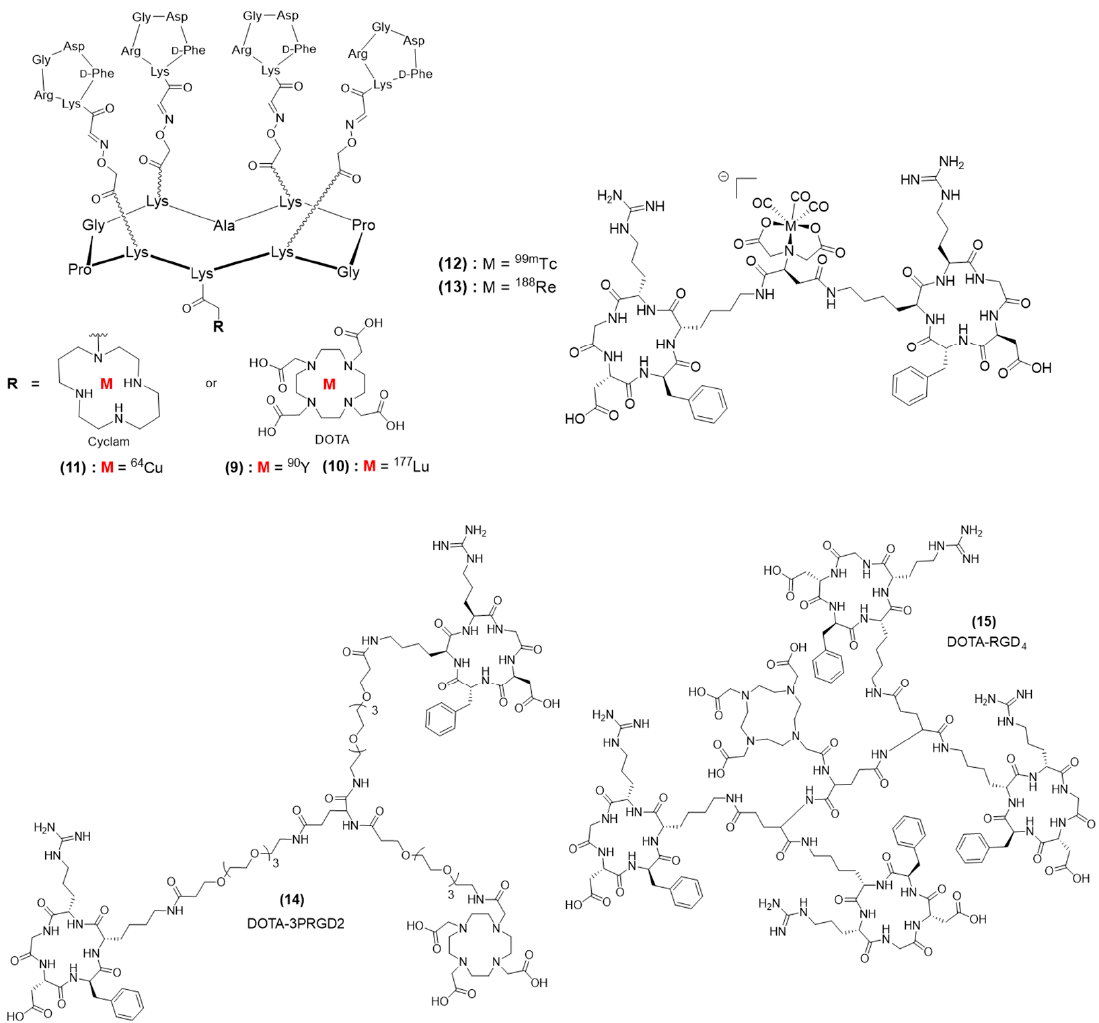
Figure 5. Theranostic multimeric RGD conjugates.